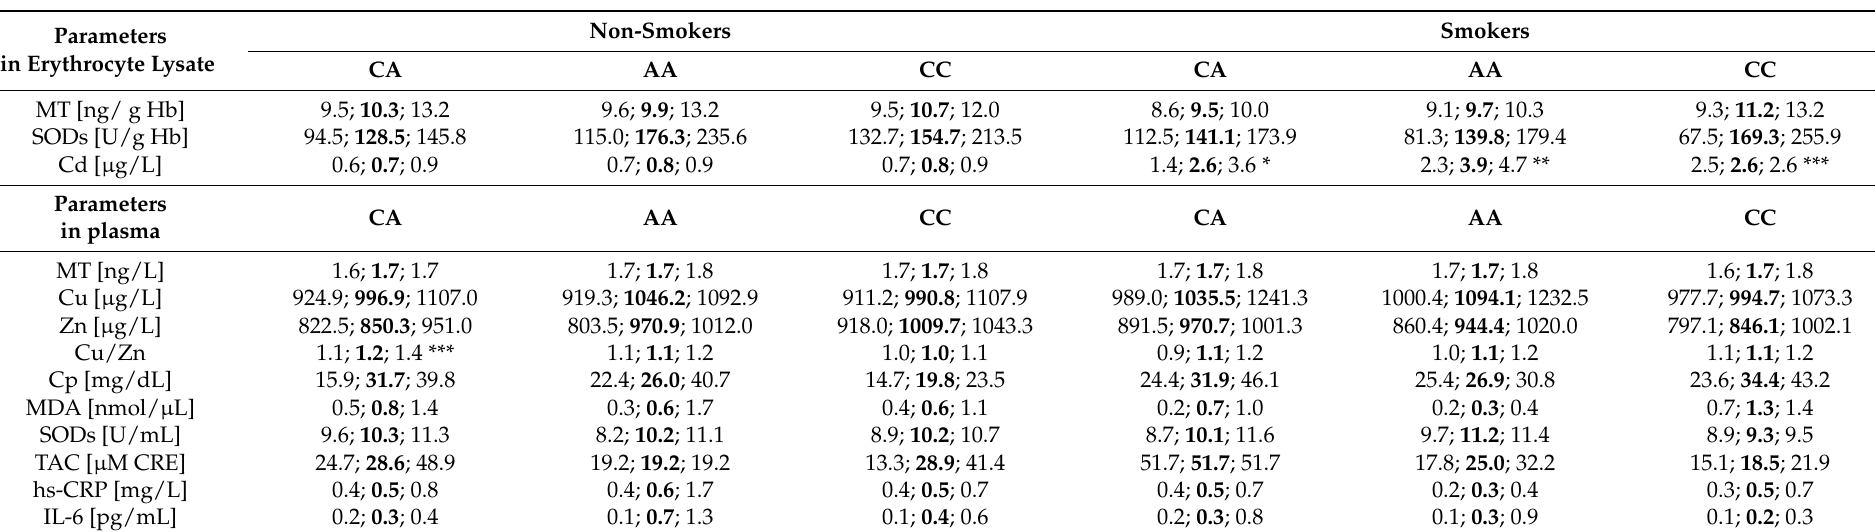
Table 3. The concentration of metals (Cu, Zn and Cd), MT, Cp and markers of inflammation and oxidative stress in groups of non-smoking and smoking healthy subjects, with regard to genotypes for rs11640851 in the MT1A gene. The bold is to distinguish the median values.